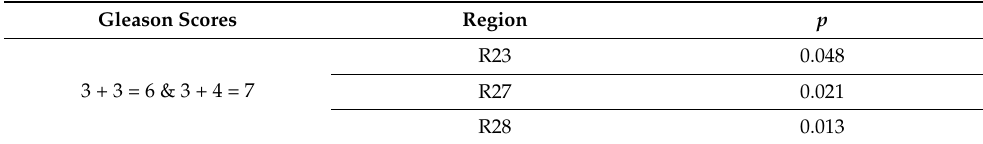
Table A6. Significant linear correlations between spectral peak intensities or principal components and the Vol.%Epi. Groups Region/PC p r R23 0.0399 0.2976 All R30 0.0008 0.4670 R1 0.0015 0.7251 R8 0.0219 0.5675 R16 0.0095 0.6257 Gr1 P11 0.0414 − 0.5146 Gr1 PC10 0.0304 − 0.5411 Gr2 R30 0.0487 0.4999 Gr3 R54 0.0006 − 0.7610